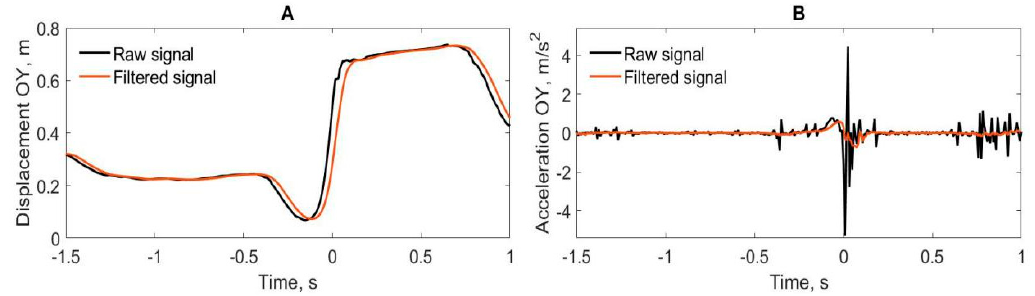
Figure 2. The example of the right-hand movement along the OY axis in Subject No. 1 in the first-person perspective (1PP) condition. ( A ) Raw and filtered data of the hand displacement. ( B ) Acceleration data obtained from the raw signal and acceleration obtained from the filtered signal. Time 0 represents the moment of peak velocity of the right hand moving along the OY axis (along the direction of the throw).